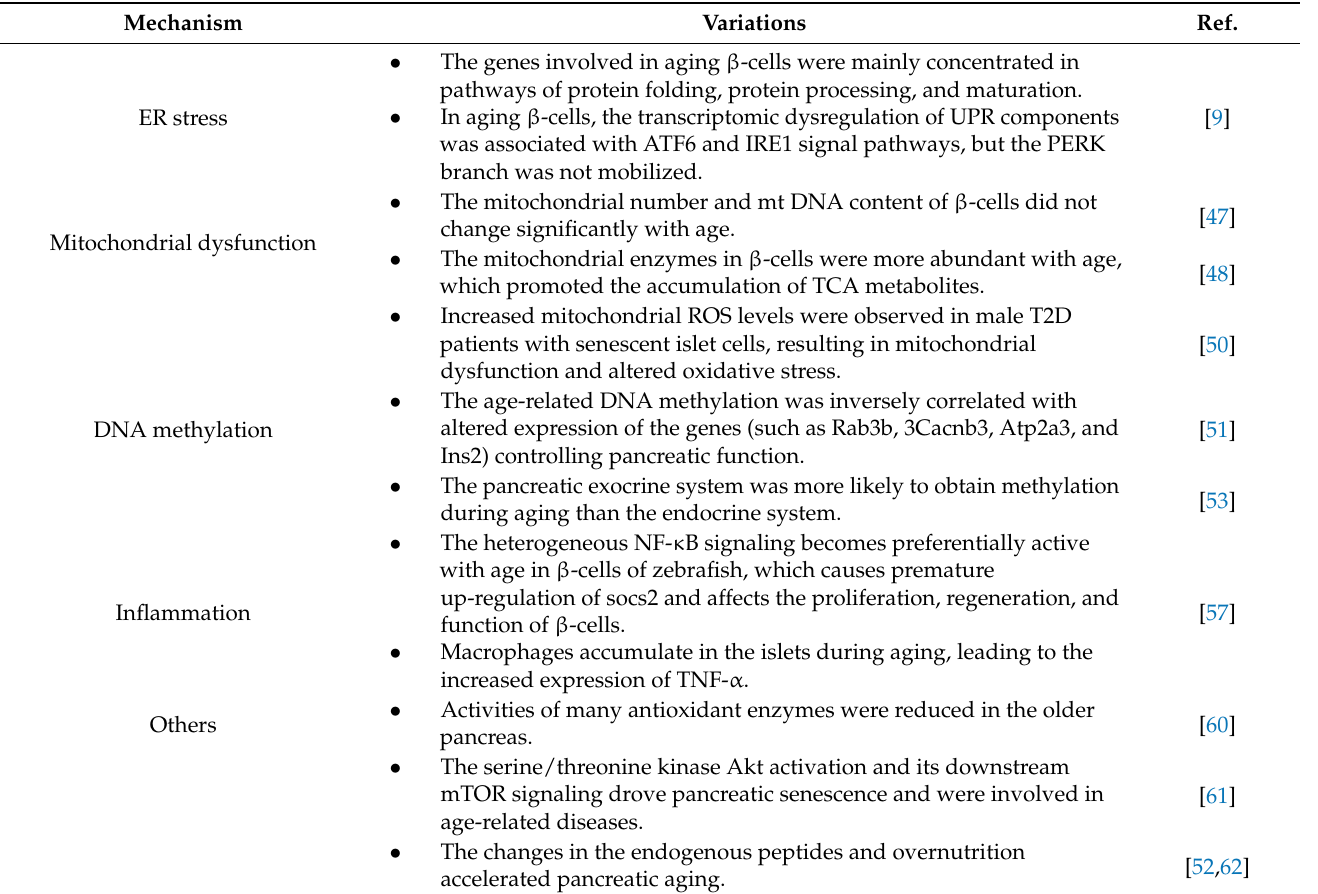
Table 2. Potential mechanisms of pancreatic senescence.